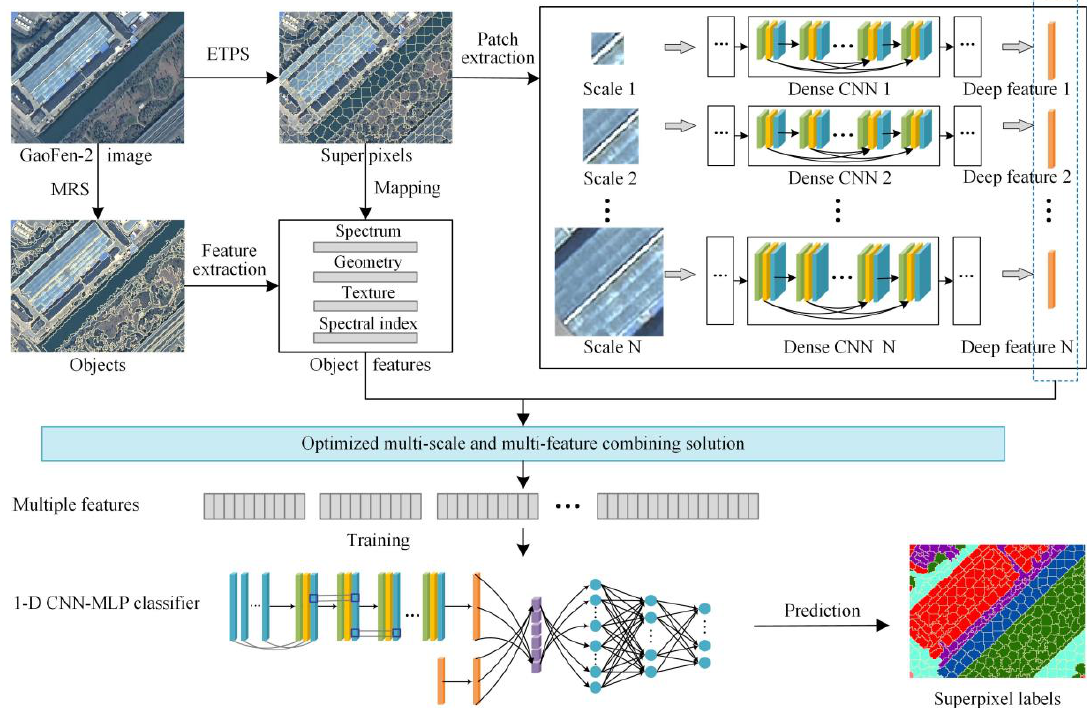
Figure 2. Flowchart of the proposed extended topology-preserving segmentation (ETPS)-based multi-scale and multi-feature method using the convolutional neural network (CNN) for high spatial resolution (HSR) image land-cover classification.